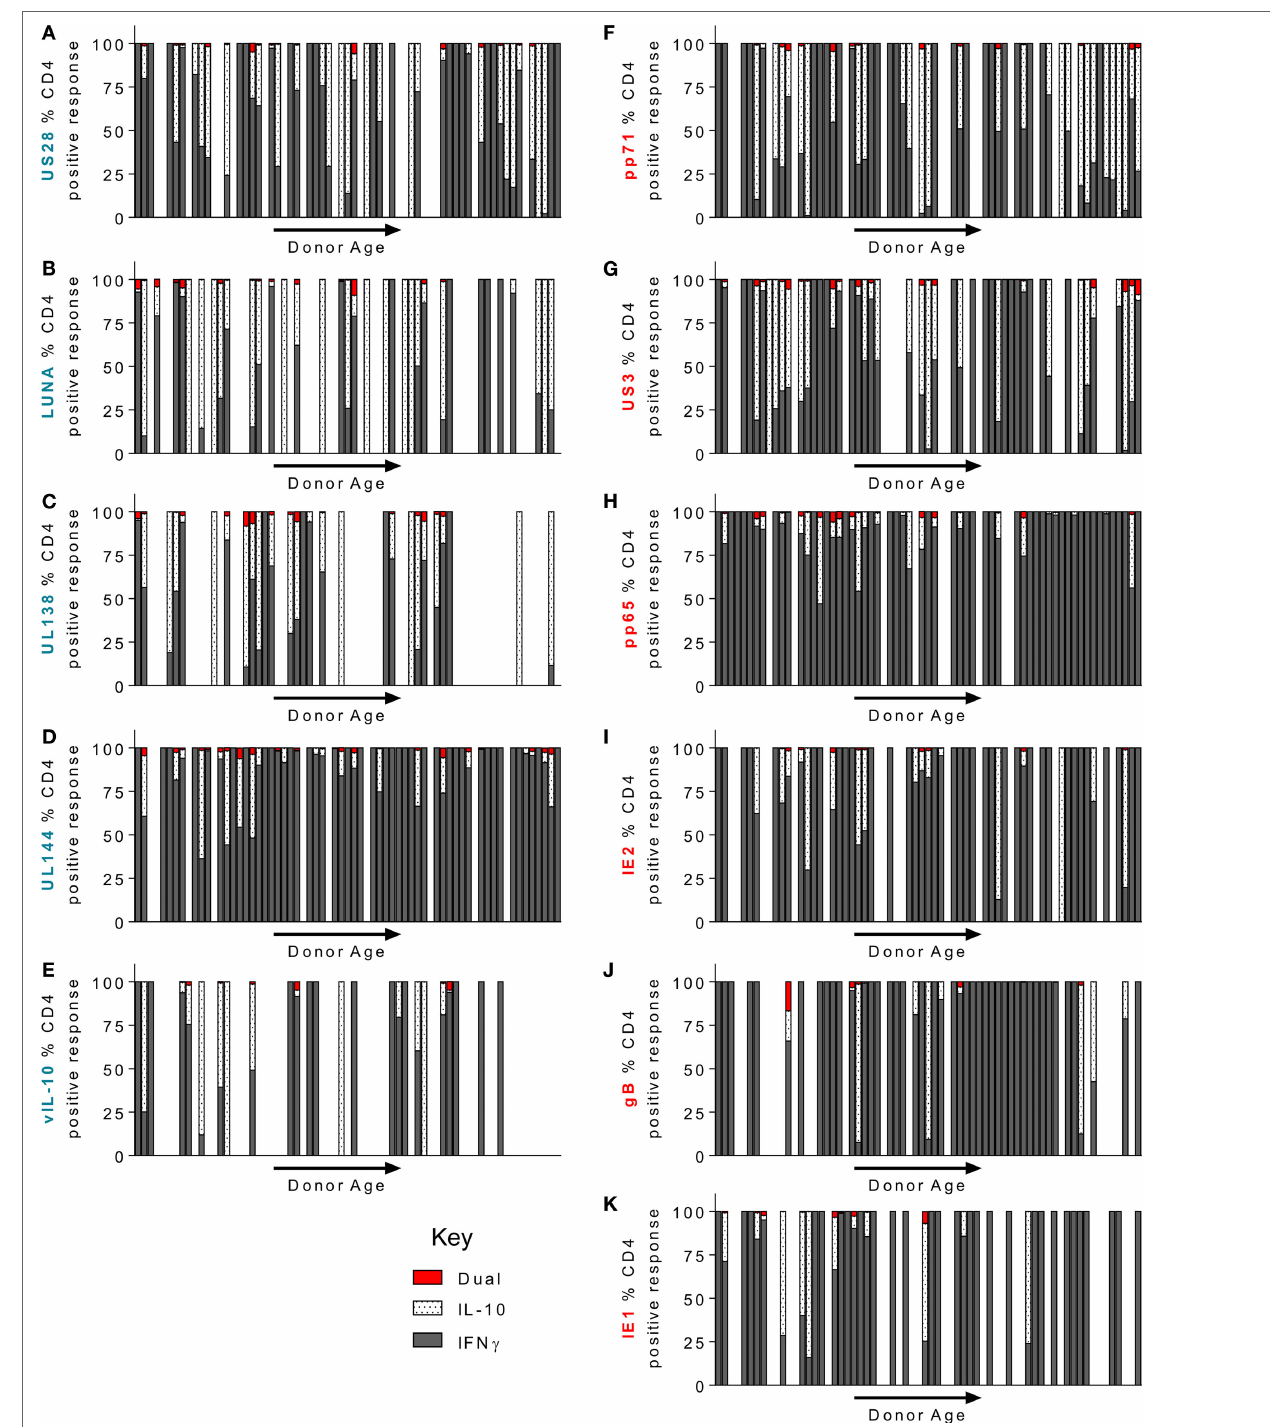
FigUre 6 | CD4 + T cell donor responses to human cytomegalovirus (HCMV) LUNA, UL138, pp71, US3, and US28 proteins were more frequently IL-10 biased. The frequency of CD4 + T cells that secrete IFN γ or IL-10 or both in response to stimulation by HCMV proteins was measured simultaneously using a dual IFN γ /IL-10 FluoroSpot assay. 67 HCMV seropositive donors were analyzed, only donors with above threshold responses for either IFN γ or IL-10 (100 sfu/million) to each protein are shown. The IFN γ (dark gray), IL-10 (white spotted), and dual cytokine (red) responses of the donor cohort to US28 (a) , LUNA (B) , UL138 (c) , UL144 (D) , vIL-10 (e) , pp71 (F) US3 (g) , pp65 (h) , IE2 (i) , gB (J) , and IE1 (K) are shown as a percentage of the total CD4 + T cell (IFN γ + IL-10) response of each donor, the donors are arranged along the x -axis in increasing age order. The lytic expressed proteins axis label is in red (F–K) and the latency-associated protein responses are labeled in blue (a–e)